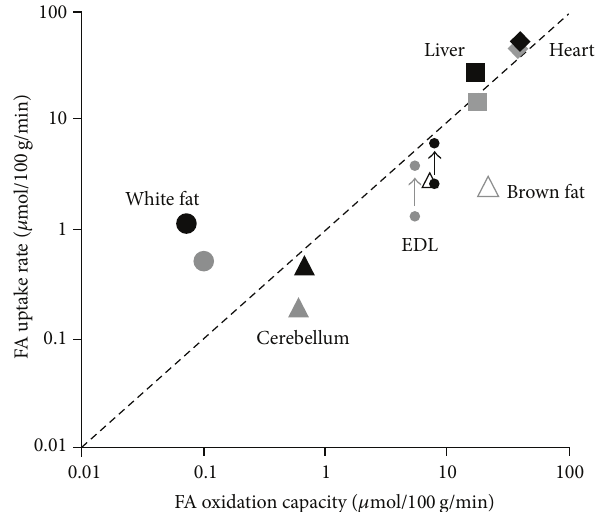
Figure 5: Relationship between FA uptake and FA oxidation capacity by individual tissues in lean (grey symbols) and obese (black symbols) Zucker rats. FA uptake has been calculated from 𝑅 ∗ 𝑓 data (see Results section). The broken line indicates equality of uptakeandoxidationcapacity.FAuptakeintheskeletalmuscle,EDL (extensor digitorum longus), was assessed in the quiescent state and during sustainable twitch contractions: arrows indicate the effect of